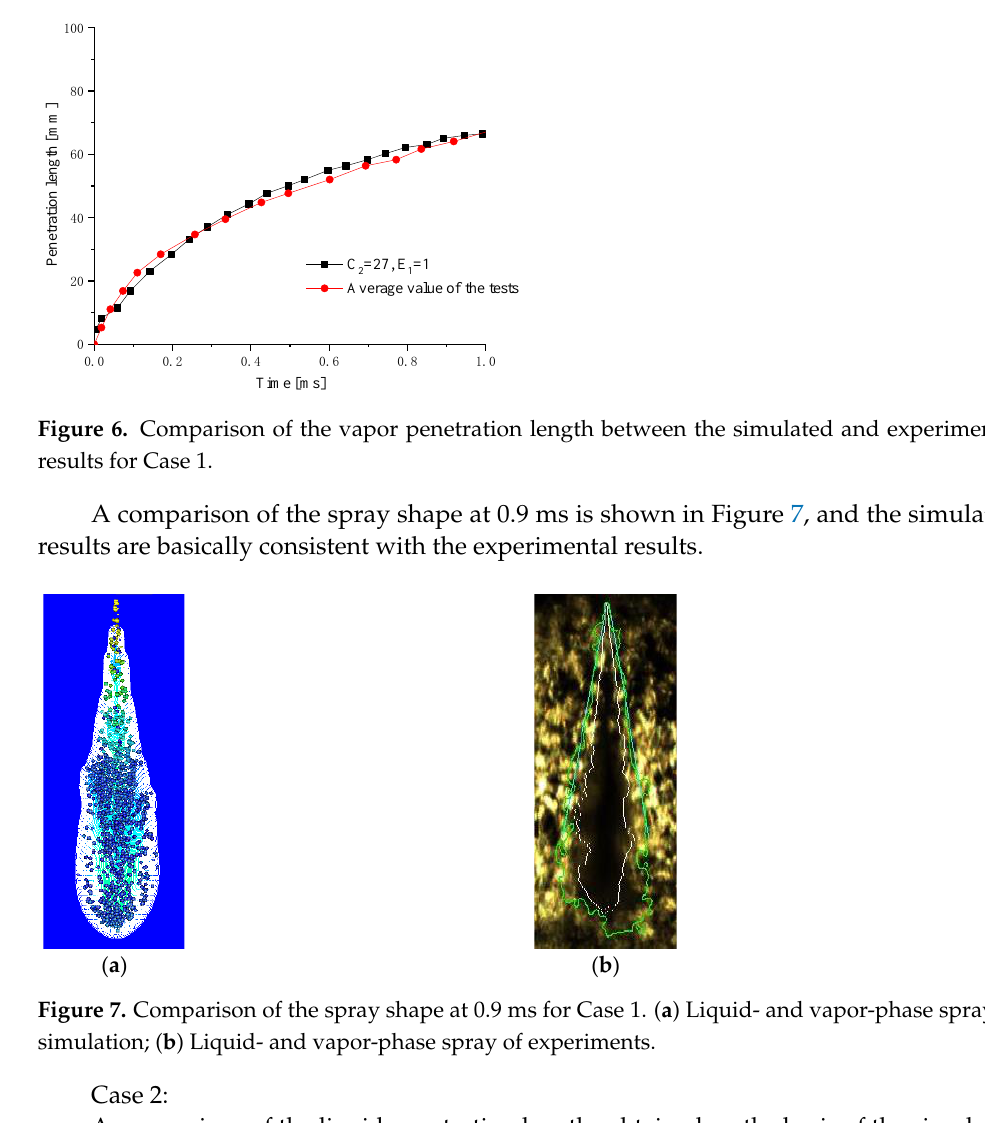
( b ) Figure 9. Comparison of the spray shape at 0.9 ms for Case 2. ( a ) Liquid-phase spray of simula- tion; ( b ) Liquid-phase spray of experiments. On the basis of the comparison of the liquid penetration lengths, vapor penetration lengths, and spray shapes in high and low ambient temperatures, it can be seen that the simulated results are in good agreement with the experimental results. The WAVE model and the parameters of the model are able to meet the requirement of the subsequent engi- neering simulation analysis.